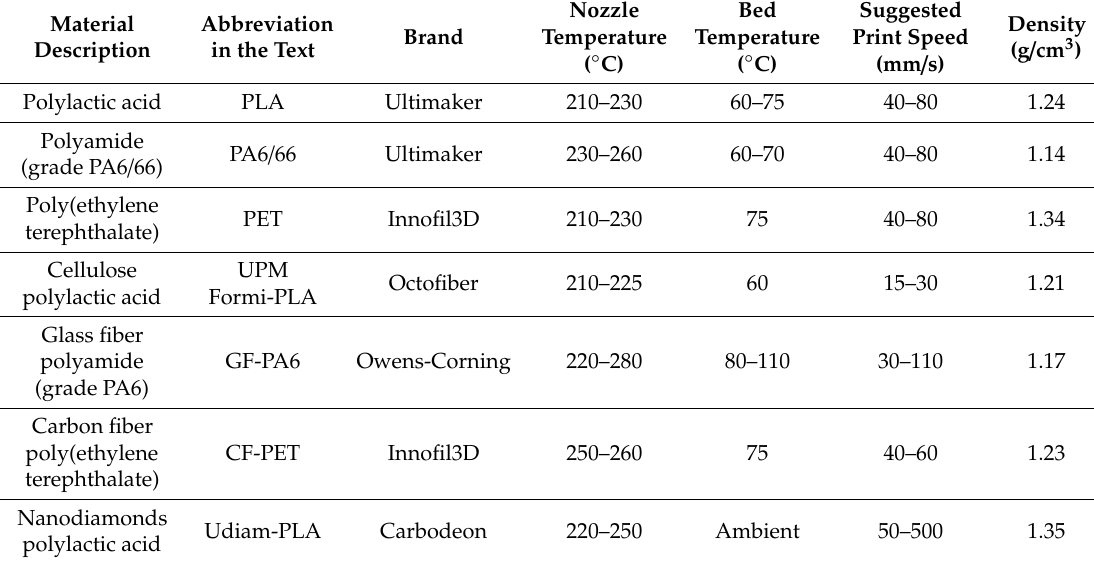
Table 1. Descriptions, abbreviations, printing conditions and characteristics of the investigated printing